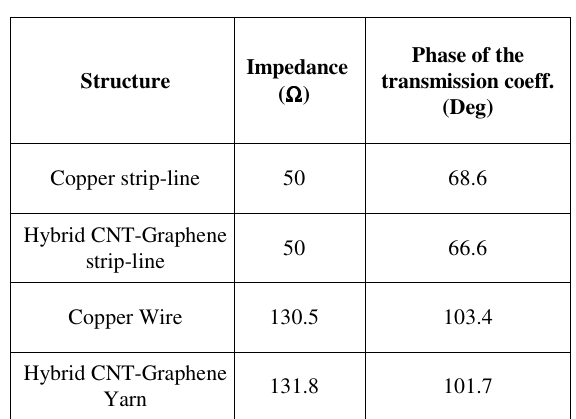
Table I. Results of a hybrid CNT-Graphene yarn and copper wire at 2.5GHz when placed on a substrate to form a transmission